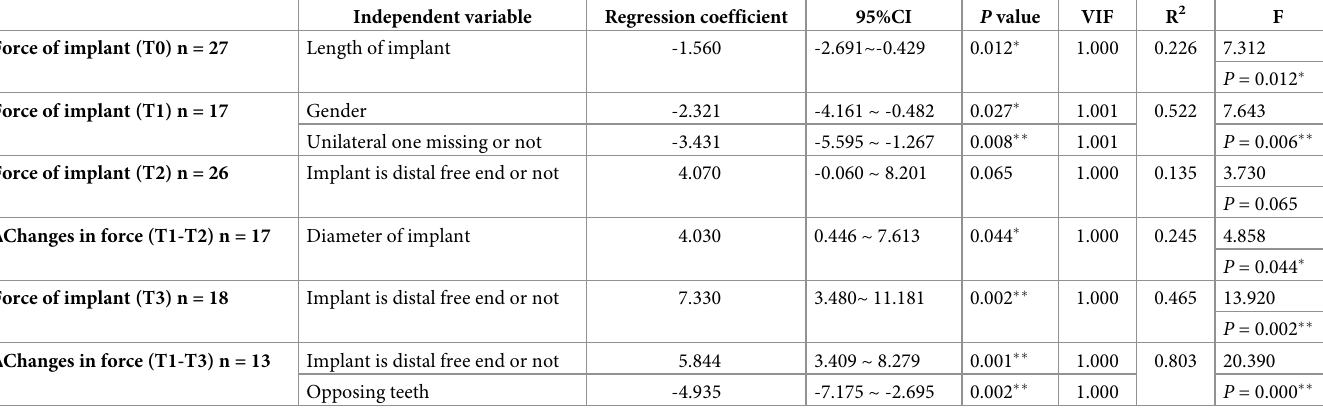
Table 8. Stepwise regression of the force distributed on the implant at different times (Group 2).